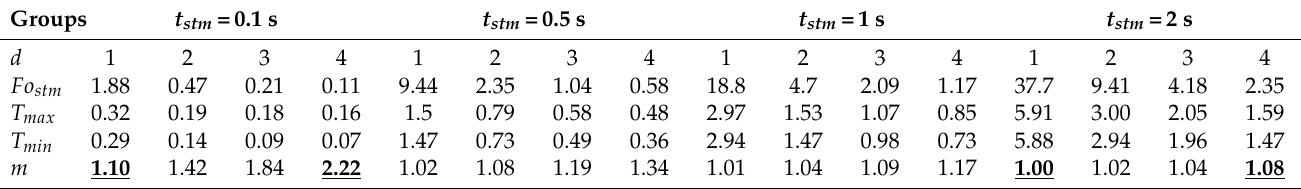
Table 3. Some temperature curve key characteristics calculated from 1D square-pulse model for various defect depths and pulse durations. A deep defect ( d = 4 mm ) subjected to a short pulse ( t stm = 0.1 s) demonstrates much larger min–max temperature ratio compare to other combinations of pulse duration and defect